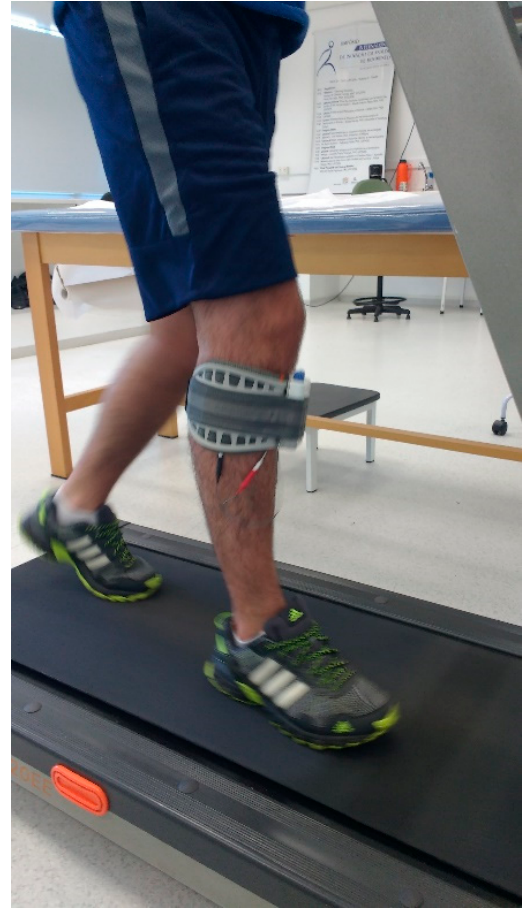
Figure 1. The experimental setup. The WalkAide device (Innovative Neurotronics, Austin, TX, USA) was used to stimu- late the peroneal nerve on the affected side through a tilt sensor that detects the affected leg tilt when the foot contact on the ground changes from posterior to anterior (pre-swing phase). The stimulus stops when the leg is tilted forward on foot strike [49,50]. Before treatment, subjects underwent a 3-day adaptation period with the FDS device that included walking overground on a flat surface, walking up and down stairs, and walking on a treadmill. The FDS device was set at enough intensity to achieve the movement, but, at the same time, was required to be comfortable. Before each session, subjects underwent 15 min of lower limb stretching and vital sign measurements. The training sessions, which were interspersed by 5 min rest periods, consisted of 20 min of walking on a treadmill. Each session was administered by the same physical therapist that annotated the overall covered distance and also periodically checked subjects’ heart rate and blood pressure. Subjects were allowed to stop the trial at any time, if